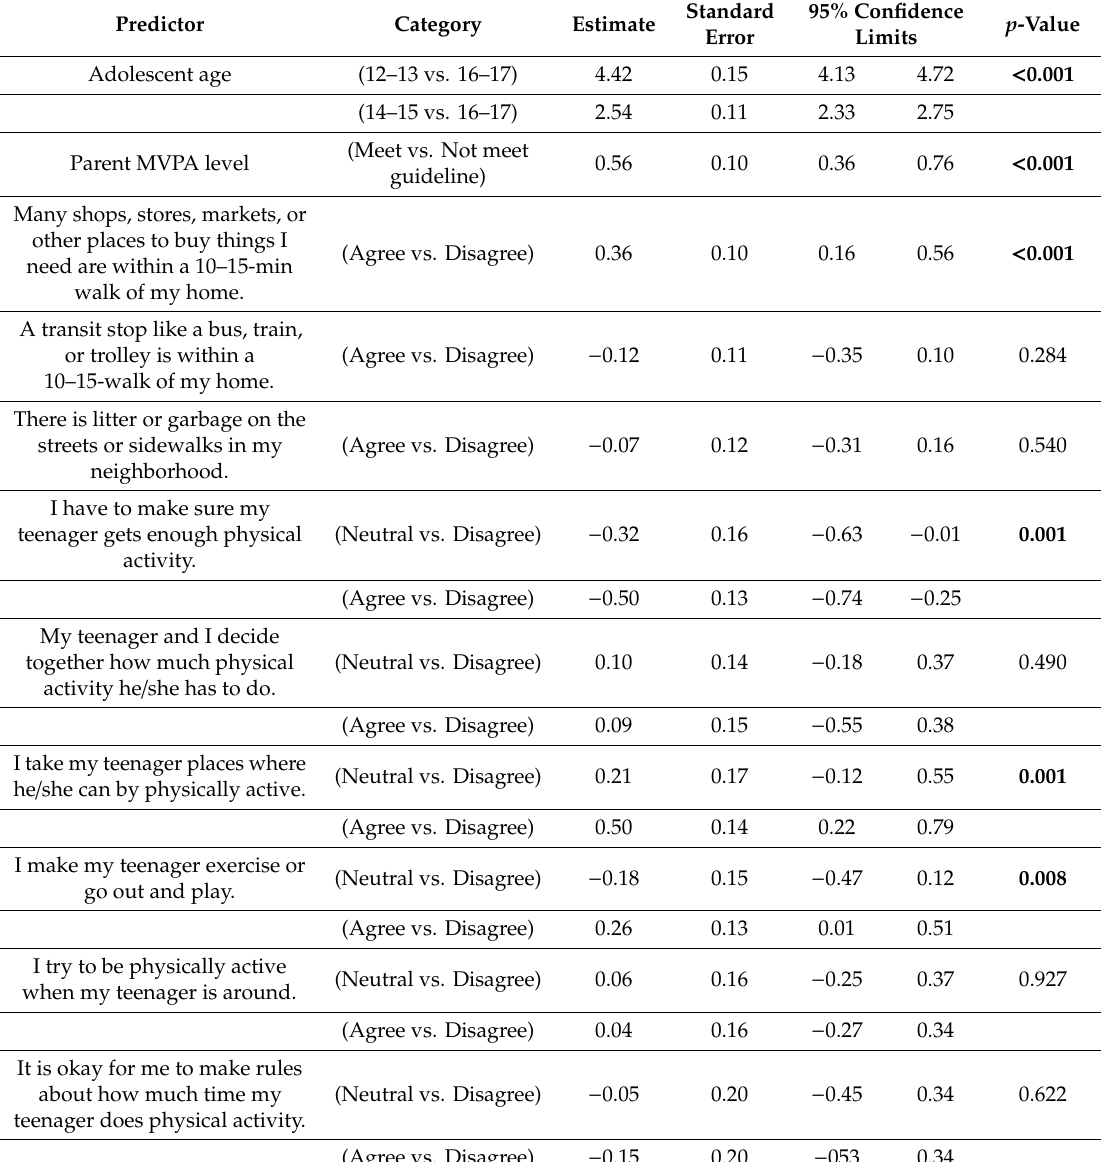
Standard 95% Confidence p -Value Error Limits